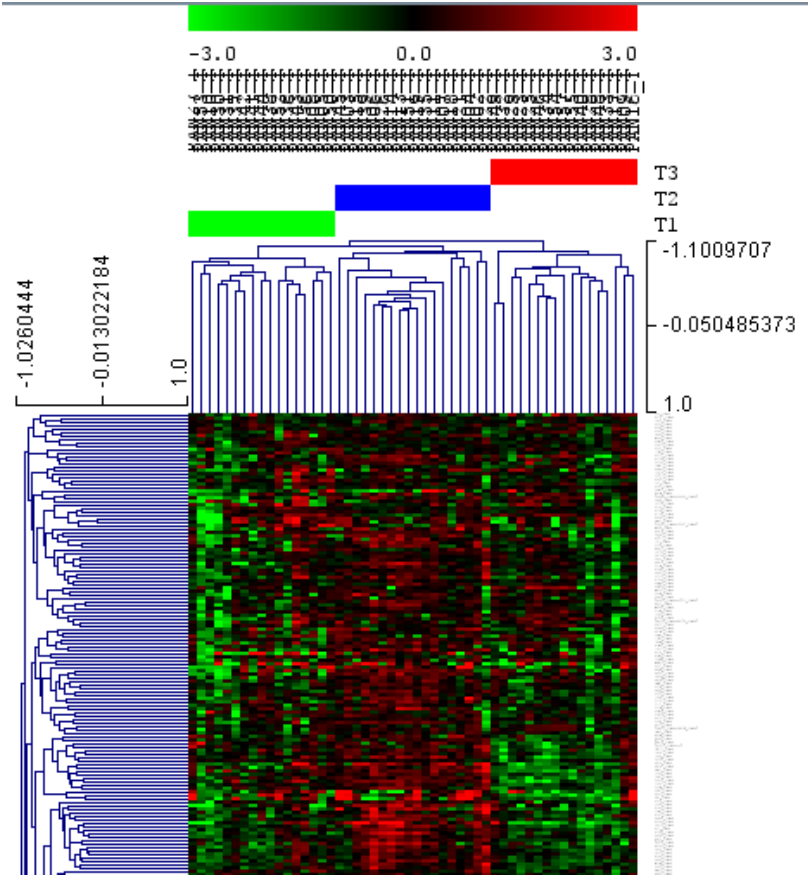
Figure 1. Hierarchical clustering (HCL) of PDAC tumor samples clearly showed three proteomic subtypes (T1, T2, and T3). HCL is based on the average linkage method and Pearson correlation. As in previous works [12,17], a network analysis based on PGMs was used to charac- terize in depth the differences at the biological processes level between the three proteomics PDAC tumor subtypes. The resulting network was divided into eight functional nodes, two of which had an overrepresentation of adhesion proteins. Functional node activities showed differences between the three subtypes. T1 presented higher functional node activities in adhesion and complement activation nodes, and will be referred as “adhesion subtype” for now on. T2 had higher functional node activities of mitochondria and metabolism and translation nodes, being for now on the “metabolic subtype”. Finally, T3 showed higher functional node activities in nucleoplasm and splicing, and will be named as “nucleoplasm subtype” (Figure